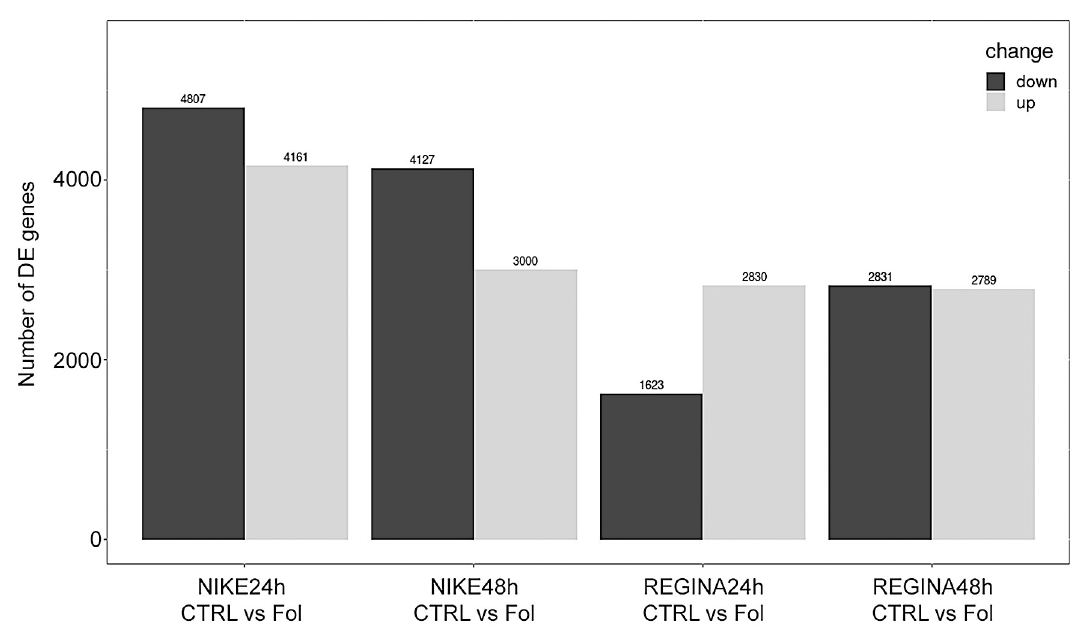
Fig 2. Statistics of differentially expressed